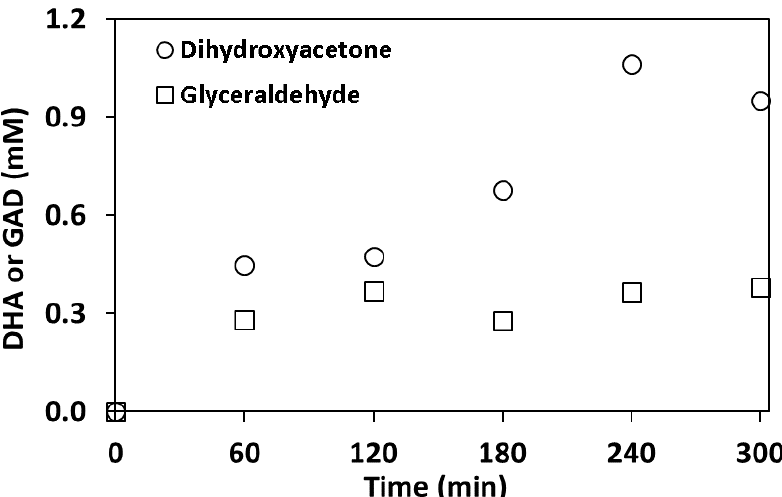
Figure 2. Photocatalytic reaction of glycerol in ethyl acetate and water under simulated solar light. The concentration of DHA and GAD in the water phase over time. Figure S3 shows a 360 min data point. Water: 10 mL, ethyl acetate: 90 mL, glycerol: 0.4 mmol, Degussa P25 TiO 2 : 0.1 g.